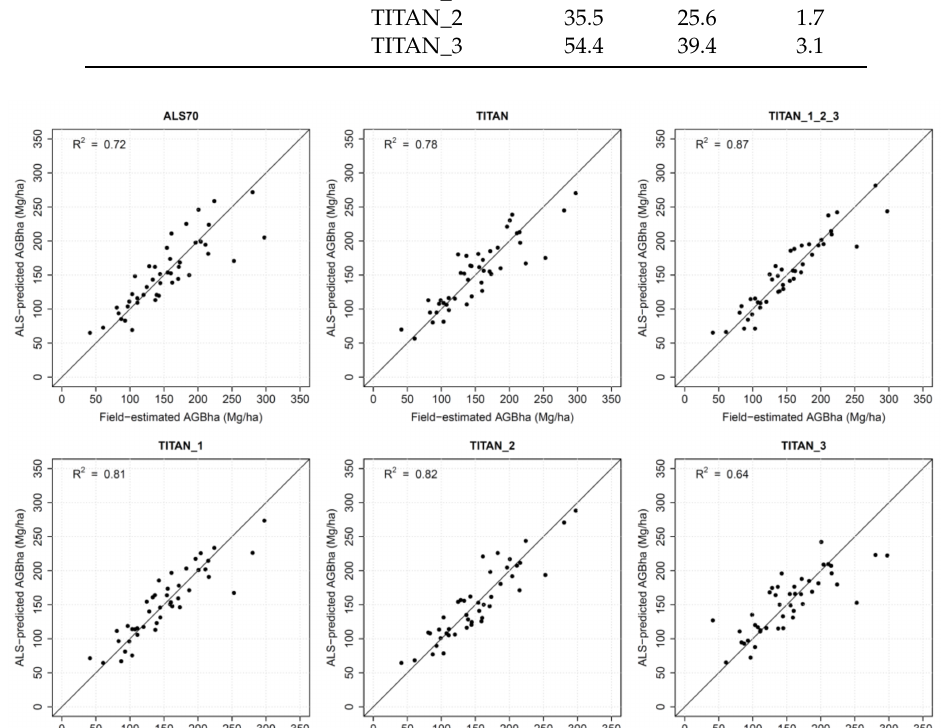
Figure 4. Scatterplots of the field-estimated and ALS-predicted values of aboveground biomass per hectare ( AGBha ) for each sub-plot for each model. In each scatterplot the Pearson’s correlation coefficient between observed and predicted values is